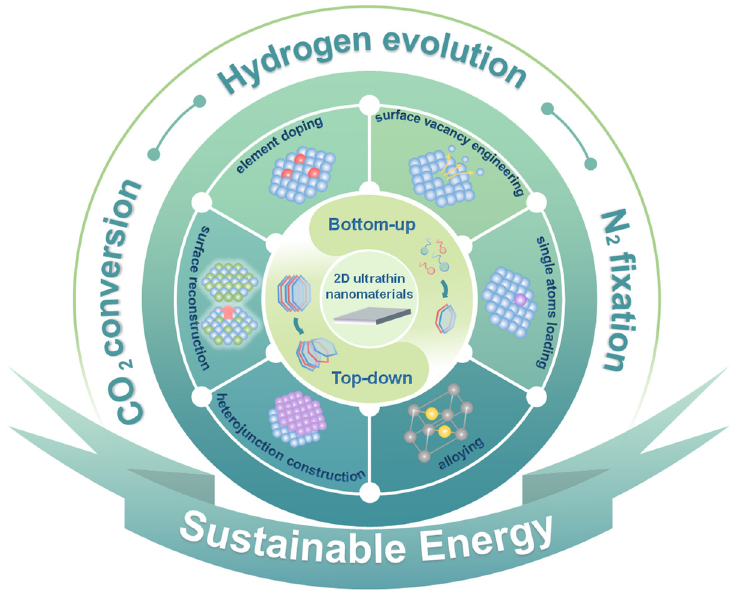
Figure 1. Schematic overview of 2D ultrathin nanomaterials topics covered in this review, including the fabrication approaches, modification strategies, and sustainable energy applications.